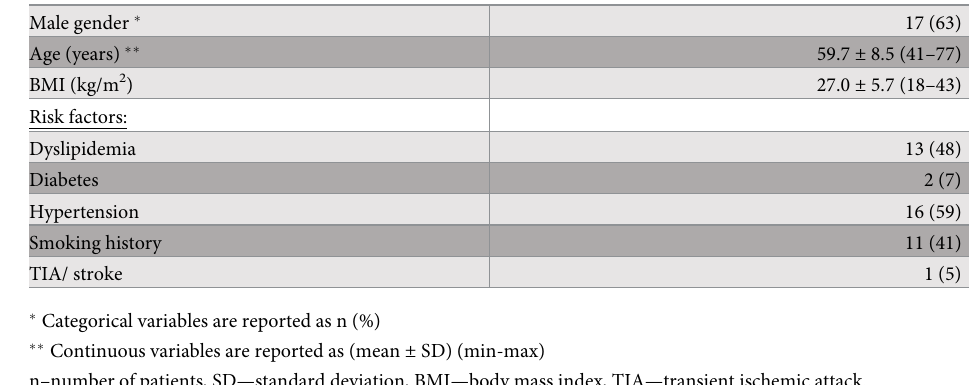
Table 2. Patient demographics (N patients =